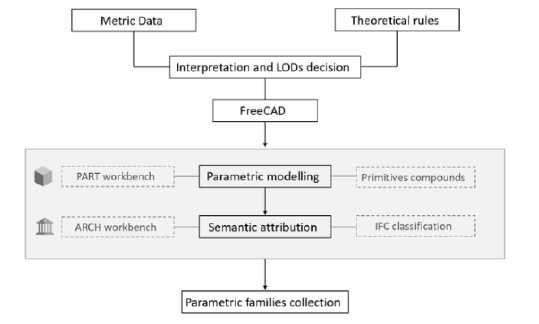
Figure 16. Design for Open-Source